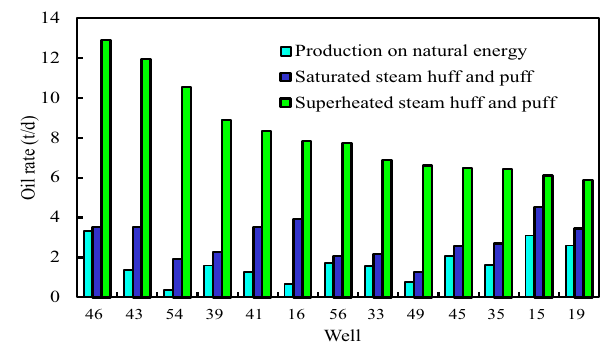
Fig. 4 Numerical model of a cyclic superheated steam stimulation horizontal well